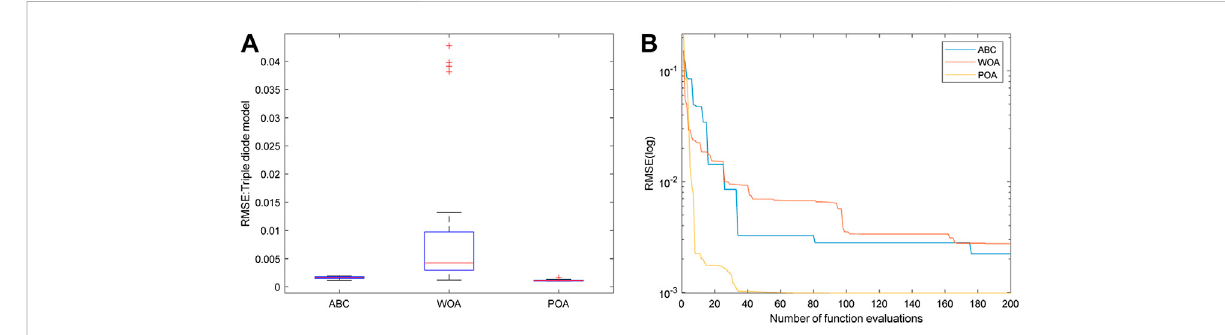
FIGURE 8 Boxplot graph and convergence curve obtained by POA for TDM: (A) boxplot graph and (B) convergence